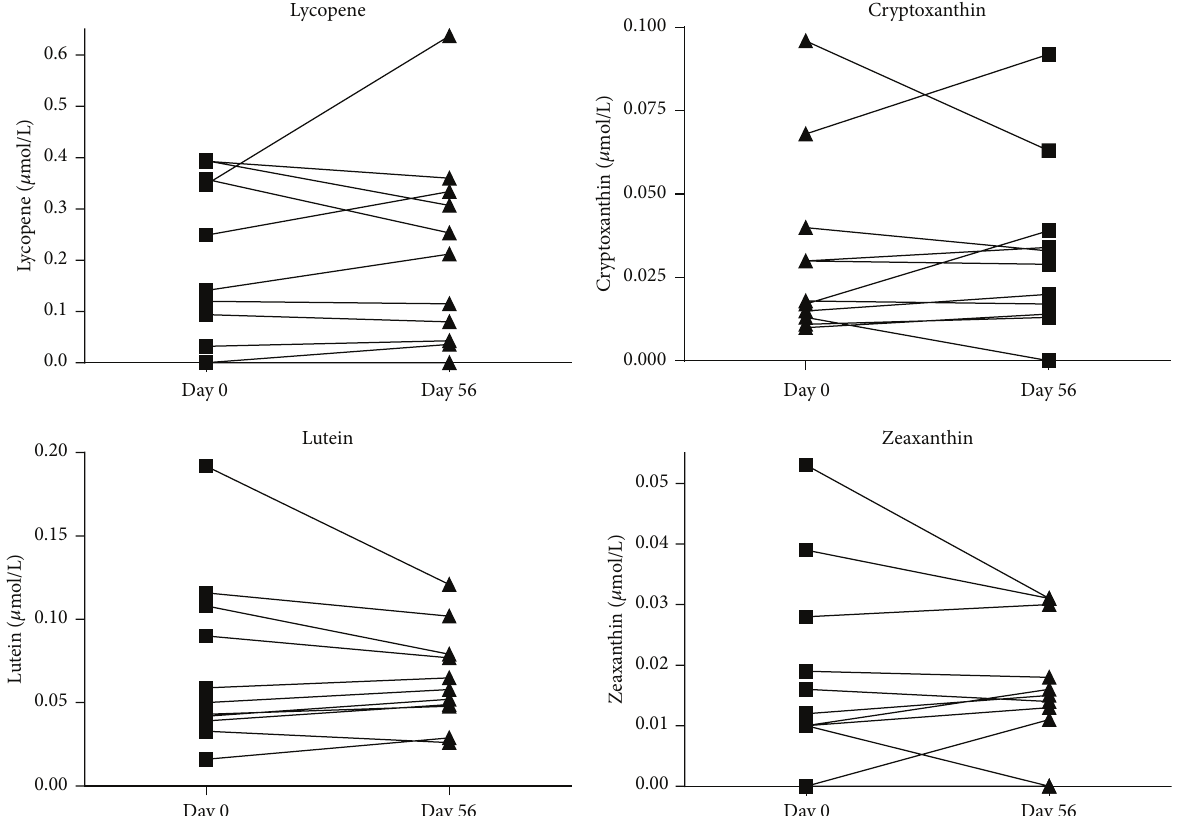
Figure 3: Plasma concentration of lycopene, cryptoxanthin, lutein, and zeaxanthin at baseline and after RPO supplementation. Values are given in 𝜇 mol/L. Concentrations of lycopene, cryptoxanthin, lutein, and zeaxanthin did not change compared with baseline.